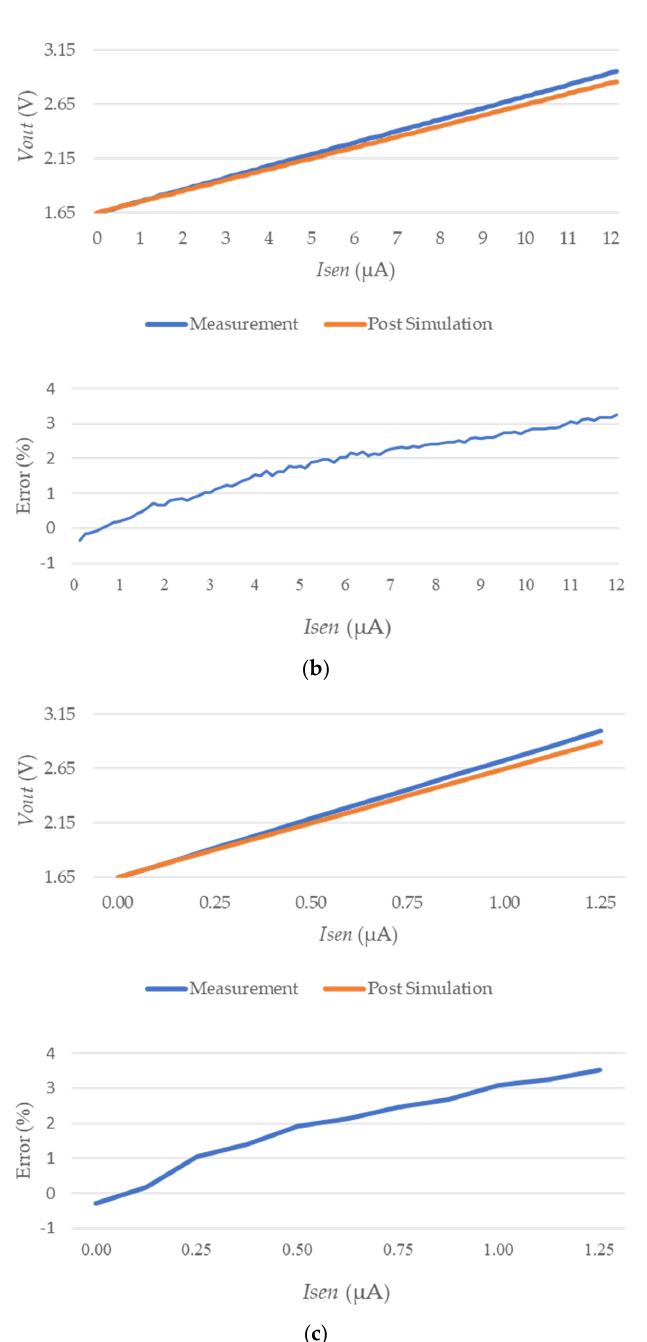
Figure 13. Comparison graphs of 𝑉 (cid:3042)(cid:3048)(cid:3047) versus 𝐼 (cid:3046)(cid:3032)(cid:3041) and error between the measurement result and